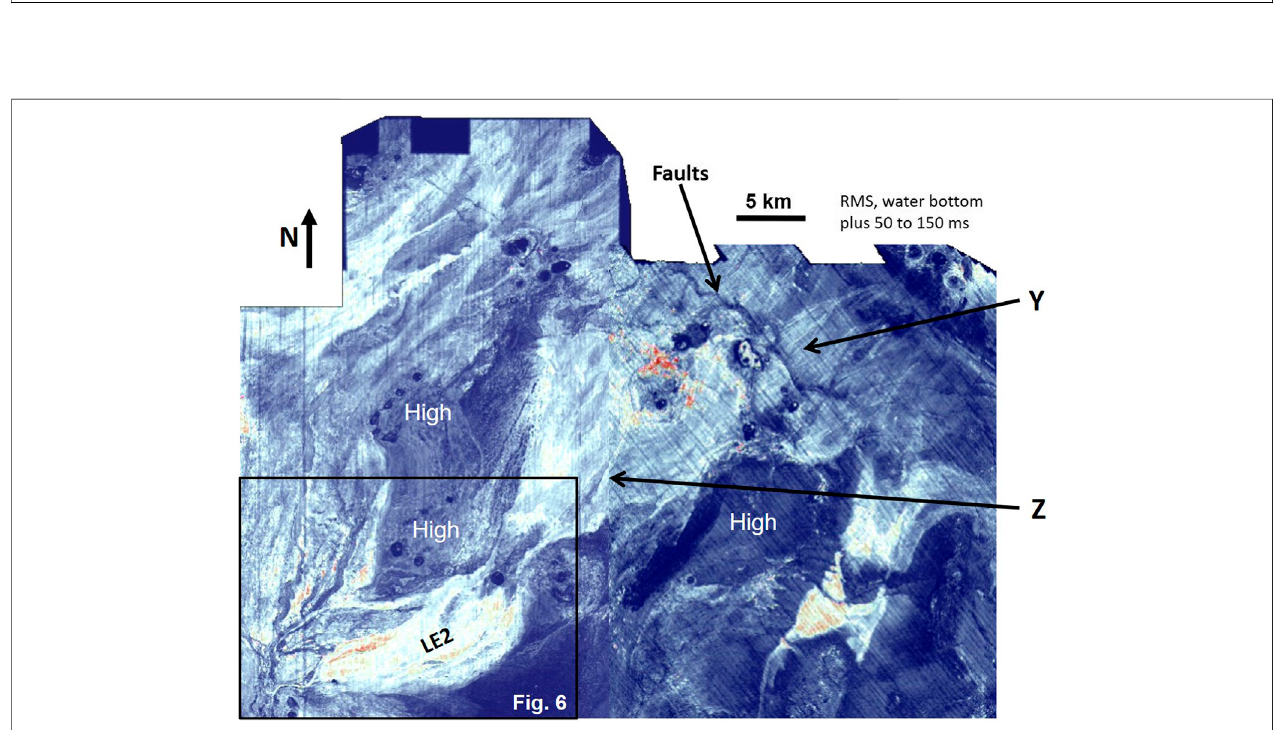
FIGURE5| ARootMeanSquared(RMS)amplitudeextractionfromtwoadjacent3Dre fl ectionseismicvolumesonthemiddletoupperslope,offshoreNigeria.See Figure4 forlocation.Theimageiscalculatedfromtheintervalbetween50and150 milliseconds(approximately100 mofsediment)belowseabed.HighRMSvaluesare displayed as white to orange colors. Sediment transport is from northeast to southwest. The location of panel 6 is indicated. In fl uential structural highs are annotated (High). The location of LE2 is labeled, as are the locations of areas Y and Z (discussed in the text).